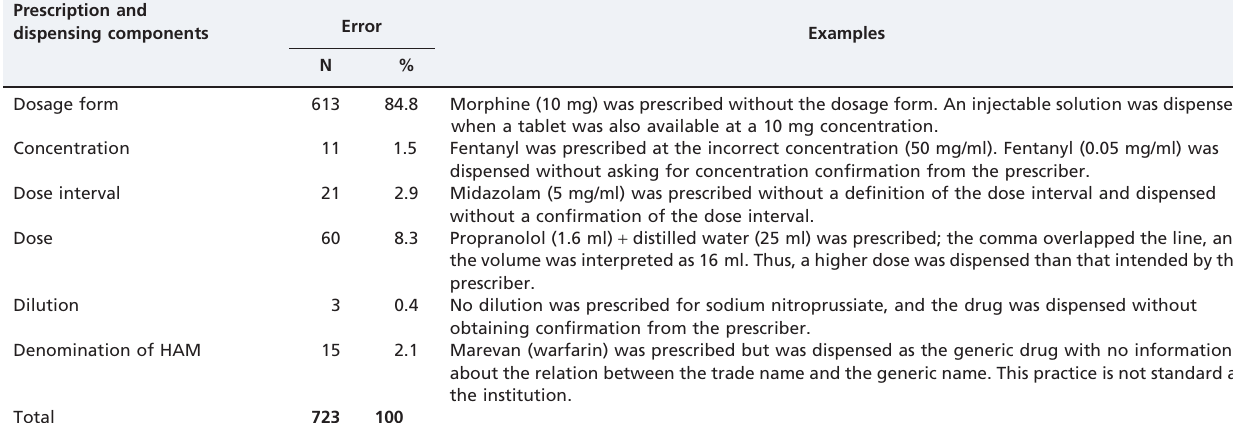
Table 3 - Description and examples of concomitant prescribing and dispensing errors by prescription component. Prescription and dispensing